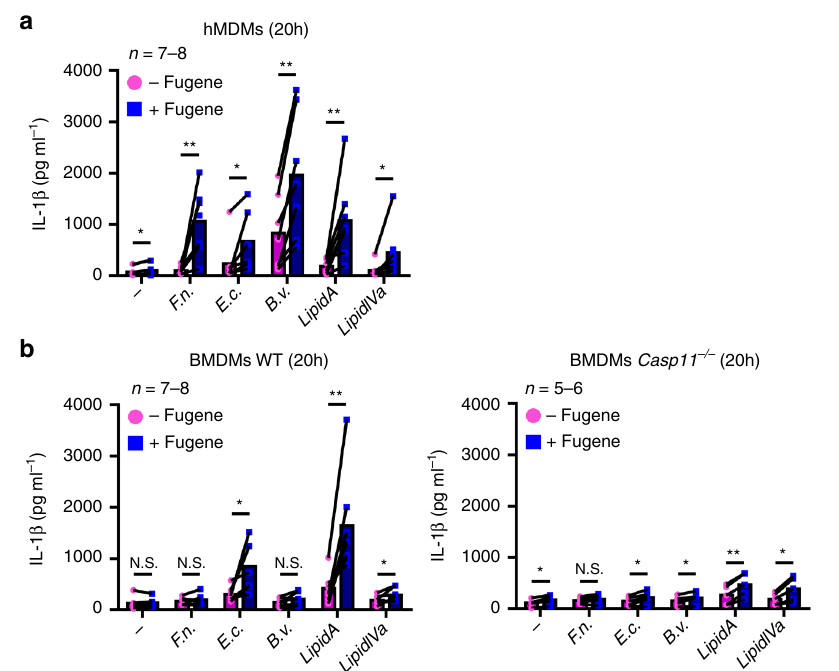
Fig. 6 Macrophages respond to various under-acylated LPS and to synthetic tetra-acylated lipid A in a species-speci fi c manner. a hMDMs and b BMDMs from the indicated genotype were primed overnight with IFN- γ followed by priming with Pam3CSK4 and treatment or transfection with buffer ( − ) or with 5 µ g.mL -1 of lipopolysaccharide (LPS) from F . novicida ( F.n .), E. coli ( E.c .), B. vulgatus ( B.v .), or with 5 µ g.mL -1 of synthetic hexa-acylated (lipid A), tetra-acylated (lipid IVa) lipid A. IL-1 β secretion was measured by ELISA at 20 h post-transfection. Each point shows the mean value from three technical replicates for one mouse or one healthy donor. The bar shows the mean for all mice ( n ≥ 7) or donors ( n ≥ 7). The lines show the pairing of the values for a single mouse or healthy donor with or without LPS transfection (+ or − FugeneHD). Two-tailed p values with the following nomenclature (** p < 0.01 and * p < 0.05 by paired t -test) are shown, N.S. not signi fi